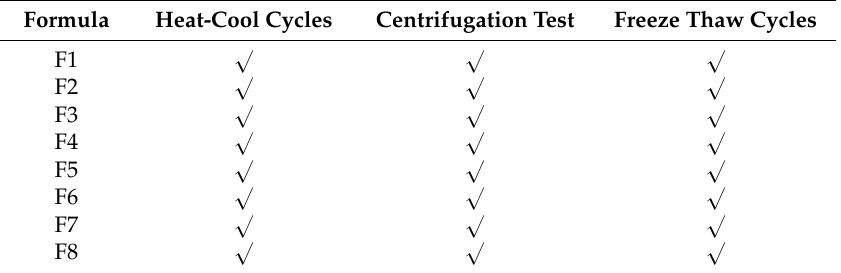
Table 4. Thermodynamic Stability Studies of Various IRB Loaded SNEDDS Formulae.